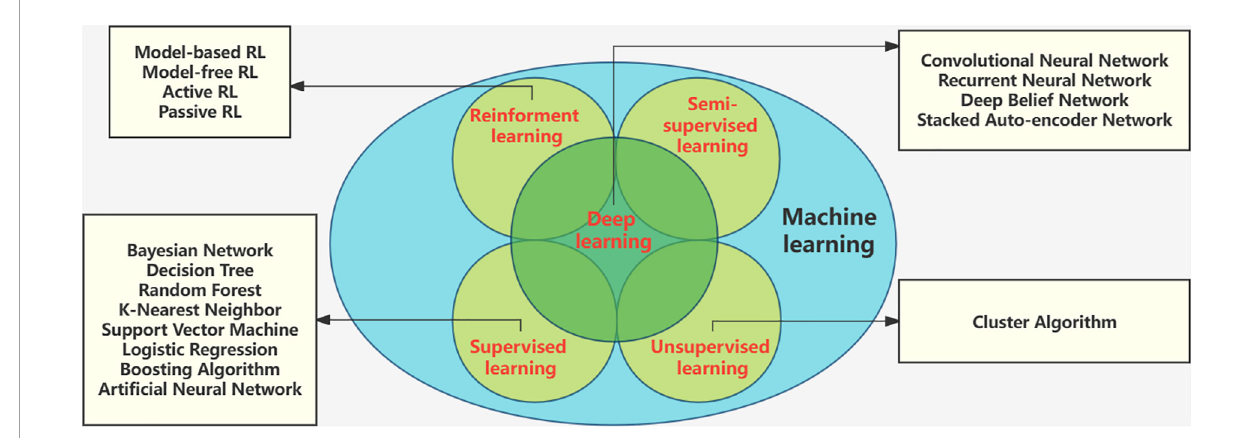
FIGURE4 Methods and technologies of machine learning.